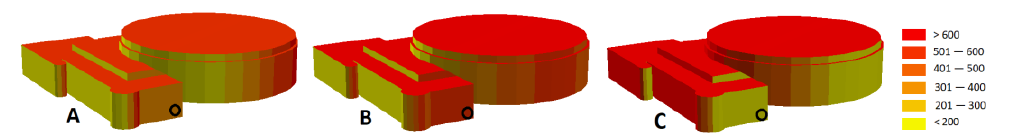
Figure 8. Solar irradiance at the Municipal Swimming Pool on 23 June 2021 (W/m 2 ) at ( A ) 9:19 a.m., ( B ) 12:09 p.m., and ( C ) 3:47 p.m. The black circle represents the measurement location. Table 4. Solar irradiance at the Municipal Swimming Pool in W/m 2 on 23 June 2021. Time